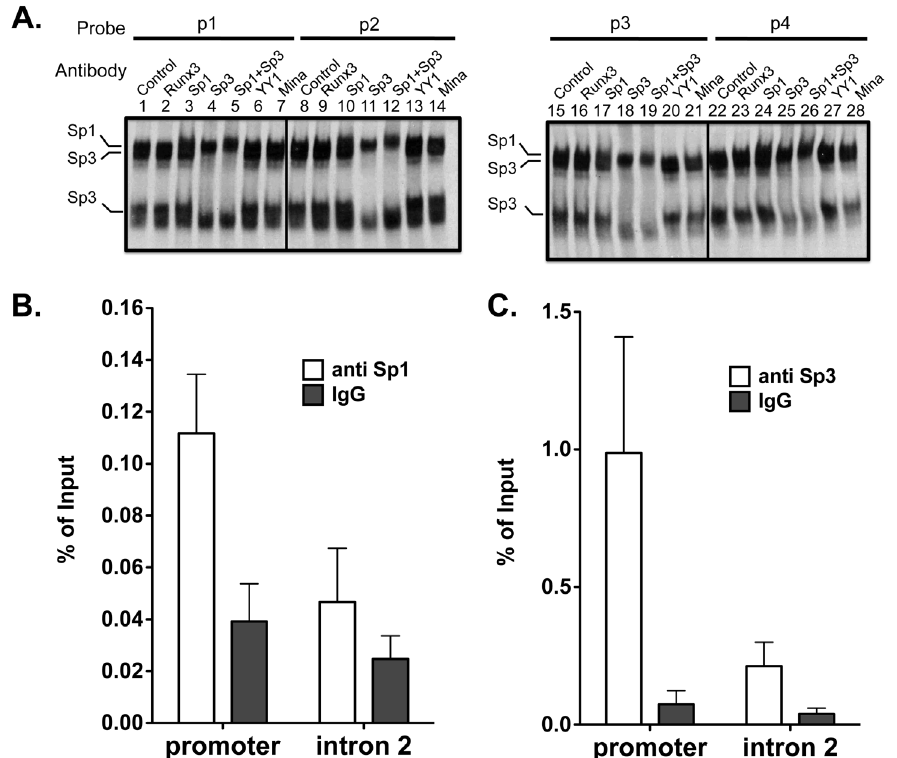
Figure 3. EMSA supershift analysis of Sp1/3 association with the four Sp1/3 binding sites comprising the Mina P1 promoter. (A) Representative EMSA assay revealing the upper and lower bands of complex 1 to contain Sp1 and Sp3, respectively, and the upper band of complex 2 to contain Sp3. Probes p1–p4 were incubated with EL4 nuclear extracts and antibodies to the indicated targets, prior to analysis by SDS-PAGE. Data are representative of 3 independent experiments. B and C) Chromatin immunoprecipitation (ChIP) analysis of Sp1 (B) and Sp3 (C) binding to the Mina P1 promoter region in EL4 cells. EL4 cell chromatin fragments were immunoprecipitated with antibodies against Sp1 or Sp3 (open bars) or control IgG (filled bars) and analyzed by qPCR. Promoter is the Mina P1-proximal promoter region; Intron 2 is located in Mina intron 2, , 6 kb 3 9 of the Mina promoter. Data are from 2 (B) or 3 (C) independent experiments.